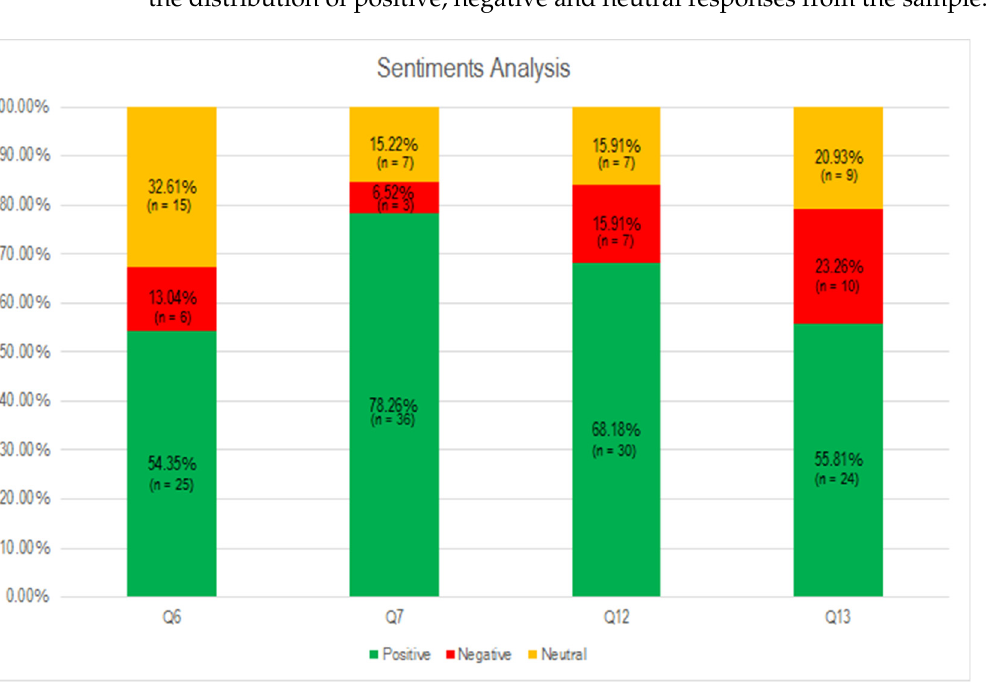
Figure 5. Sentiment analysis.